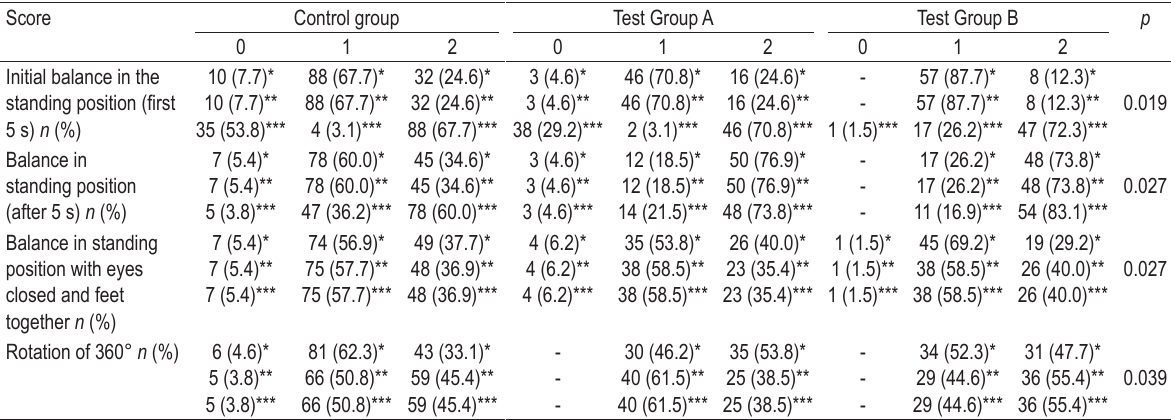
TABLE 2. Comparison of the balance elements values through three measurements in relation to the examined groups ‑ POMA B (Part II)